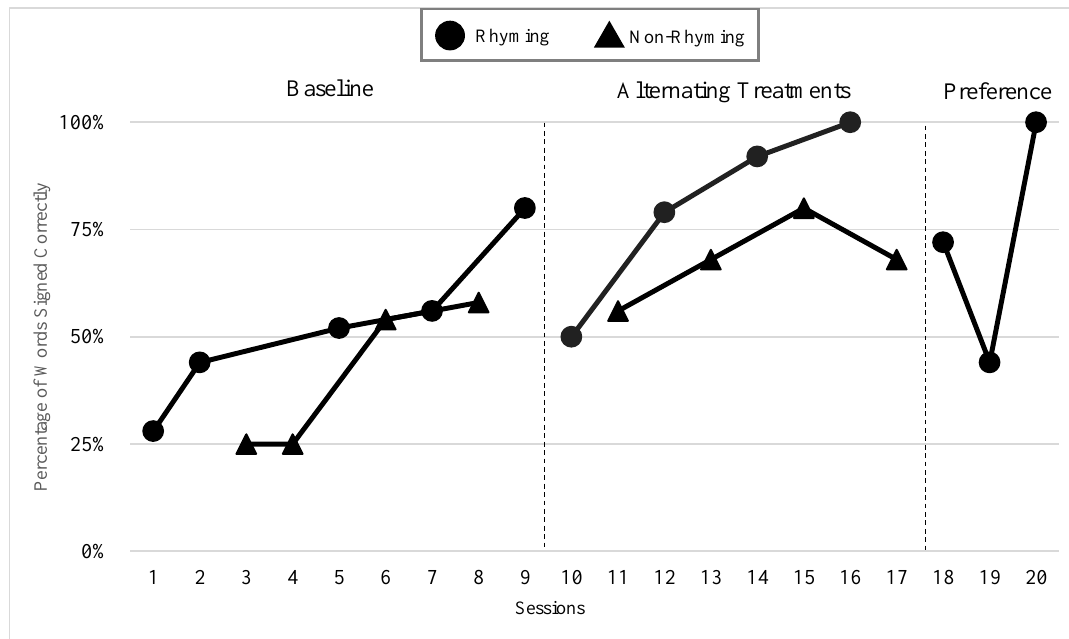
Figure 8. Daya’s Percentage of Words Signed in the Correct Order in Recitation.